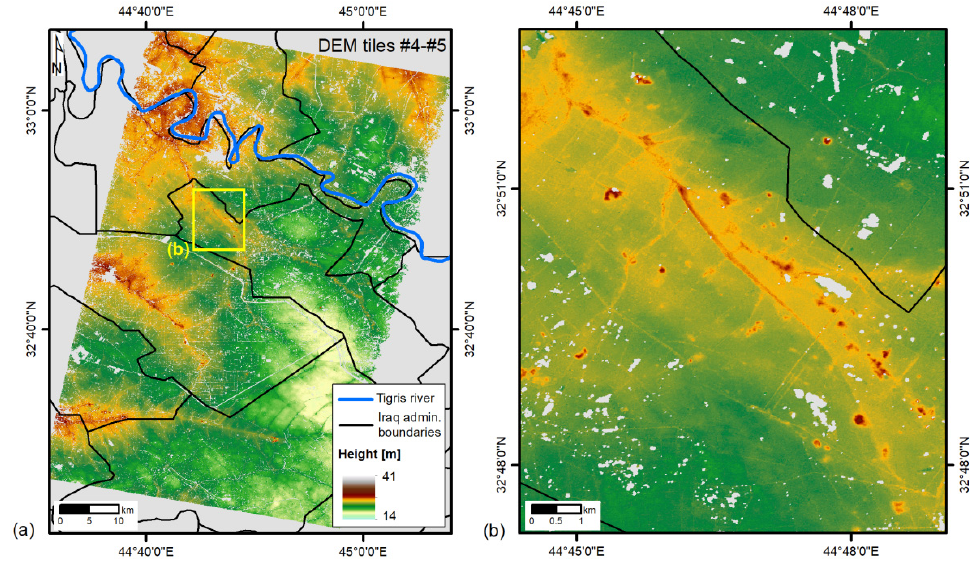
Figure 5. ( a ) Overview of high-resolution COSMO-SkyMed SM DEM tiles #4 and #5 with ( b ) zoomed view on a sector with a number of tells and archaeological deposits. COSMO-SkyMed ® Products ©ASI, Italian Space Agency, 2019. All rights reserved.